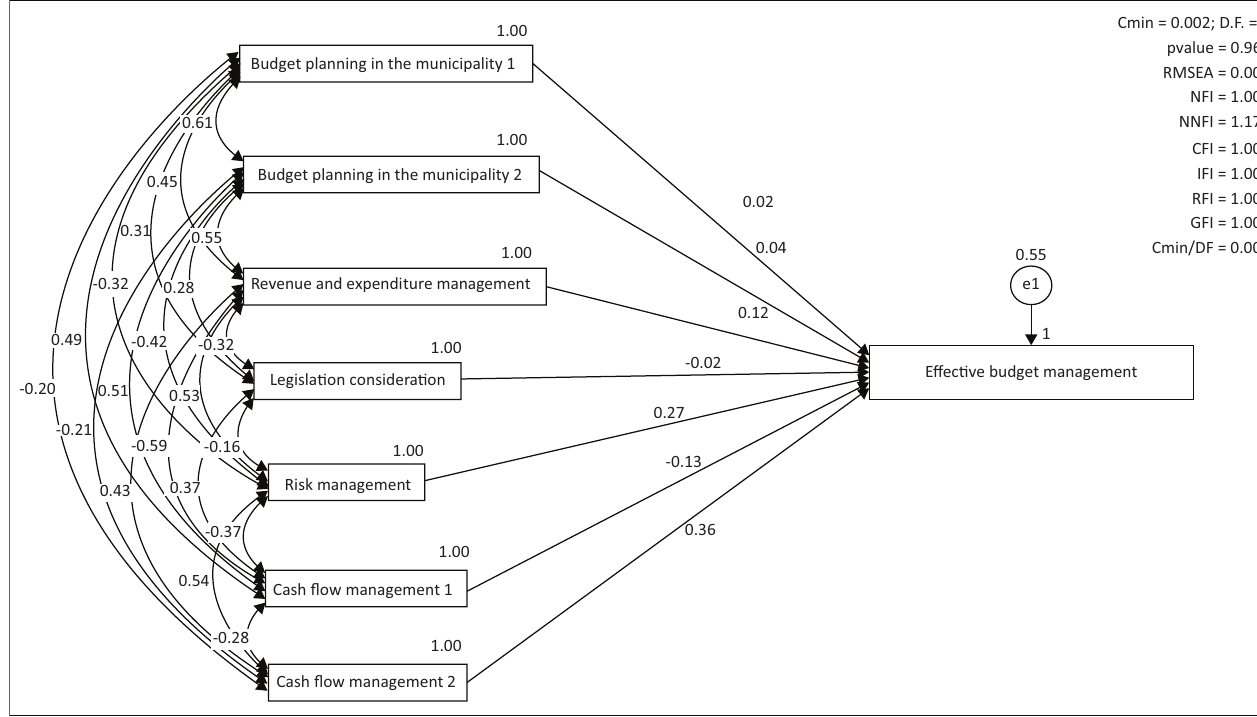
FIGURE 5: Results: Budget